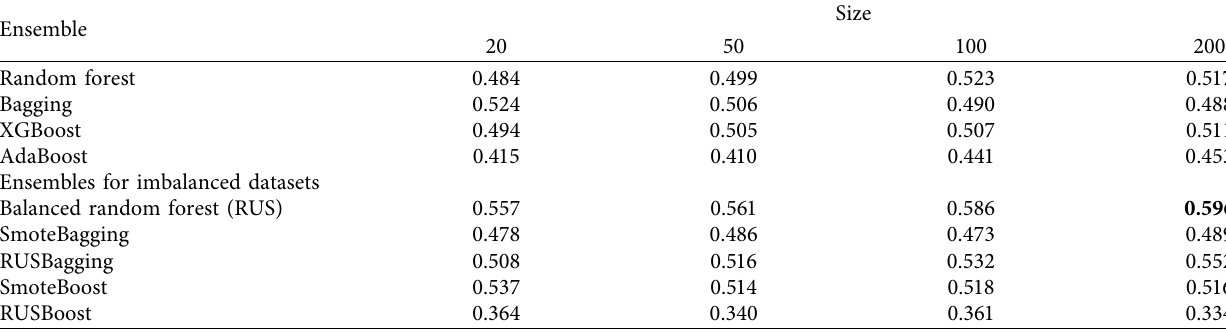
Bold numbers show the best performance. Table 7: The effect of age variable on the performance (AUROC) of various ensembles. “+” sign shows the better performance of with age or without age.